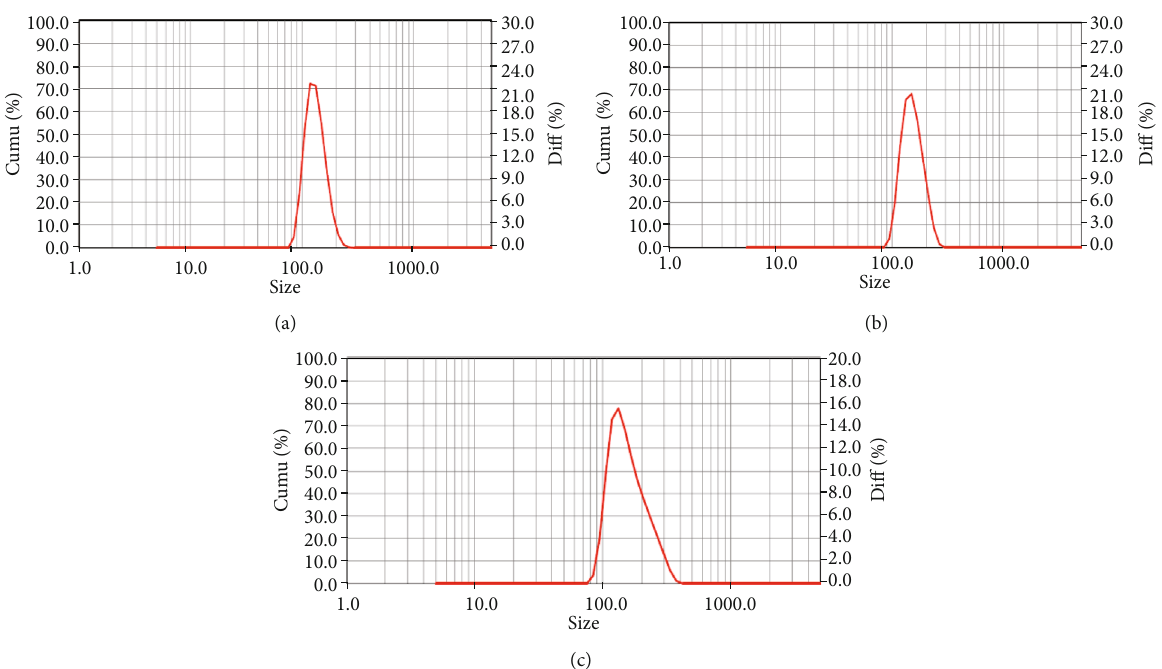
Figure 4: Particle size of GA-LDH/LS prepared by thin fi lm dispersion method (a), reverse-phase evaporation method (b), and ethanol injection method (c) ( n = 3 ).